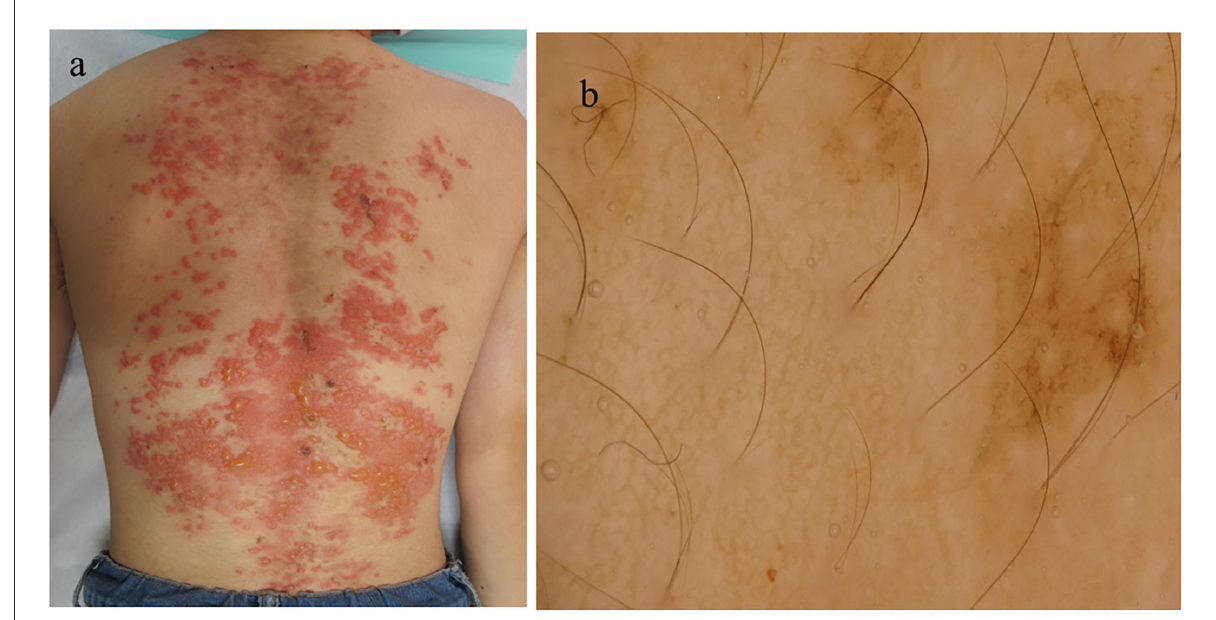
FIGURE1 Clinical and histopathological features of the patient during the first visit. (a) Clinical features on the back. (b) Dermoscopic